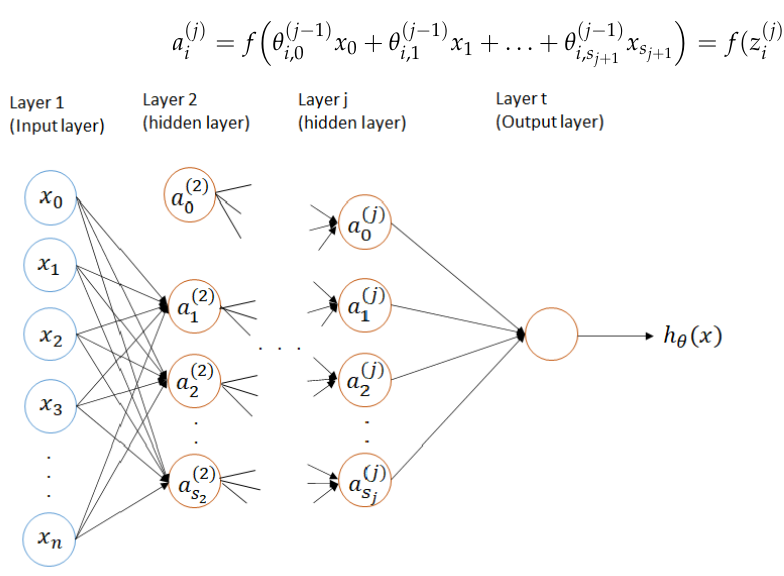
Figure 6. Artificial neural network model.